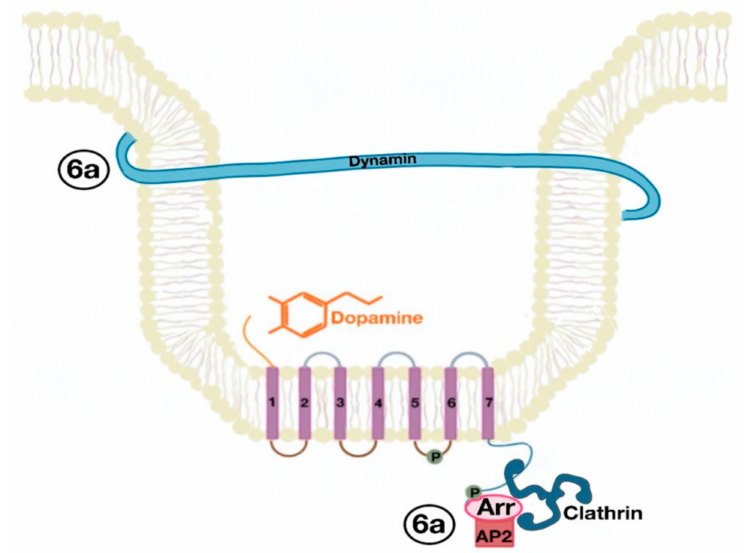
Figure 6. Dynamin and clathrin associate with the GPCR (dopamine receptor) and mediate its endocytosis by means of the adaptor protein 2 (AP2)